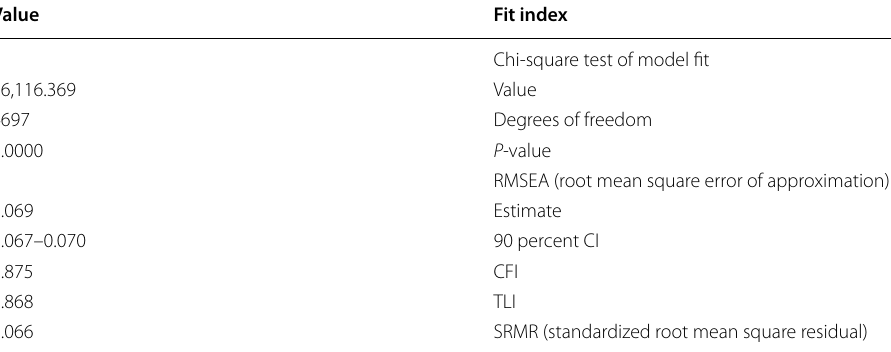
Table 4 Open innovation model fit for the second-order model